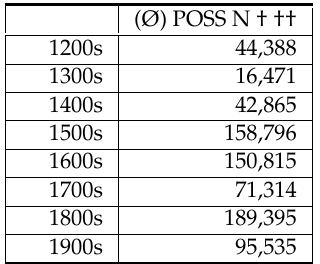
Table 9. Ø + POSS + N in CdE (raw occurrences).